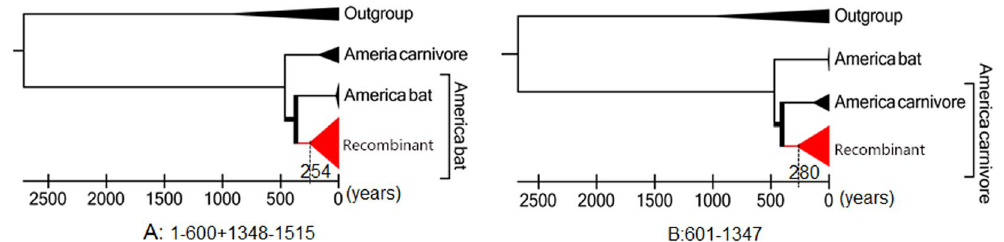
Figure 4. Estimation of the age of the recombination event using Bayesian Markov chain Monte Carlo (MCMC). ( A ) Bayesian tree based on the region outside the two breakpoints. ( B ) Bayesian tree based on the region between the two breakpoints. The scale axis shows the years to 2013. The dotted line indicates the time to the most recent common ancestor (tMRCA) of the recombinant